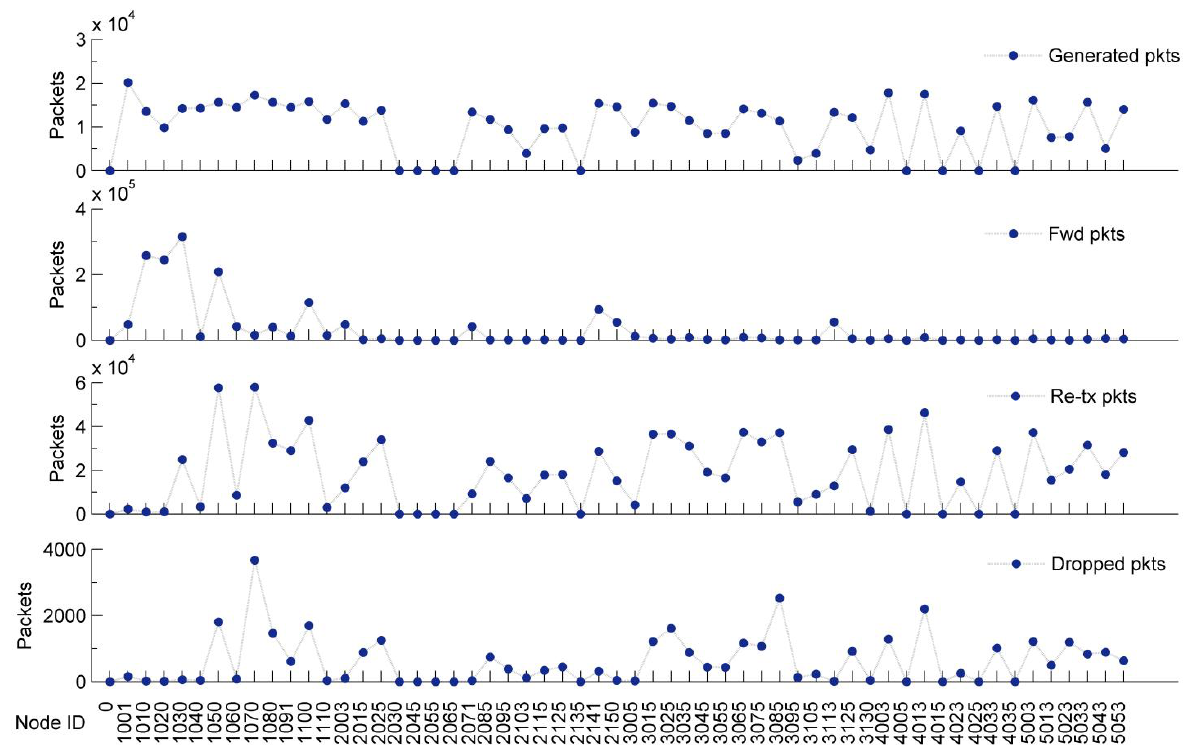
Figure 14. Node-level health information totals for packets generated, forwarded, retransmitted and dropped during the CTP evaluation